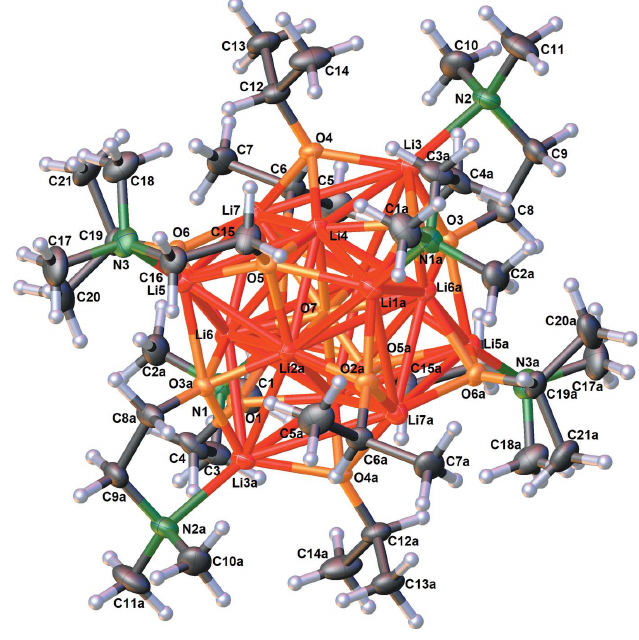
Figure 1 Molecular structure of compound 1 [Li 7 ( i -PrO) 3 (C 4 H 10 NO) 3 ] 2 O with atom labeling. The asymmetric unit is half of the compound, symmetry (cid:3) x , 1 (cid:3) y , 1 (cid:3) z operation a = 3 2 2